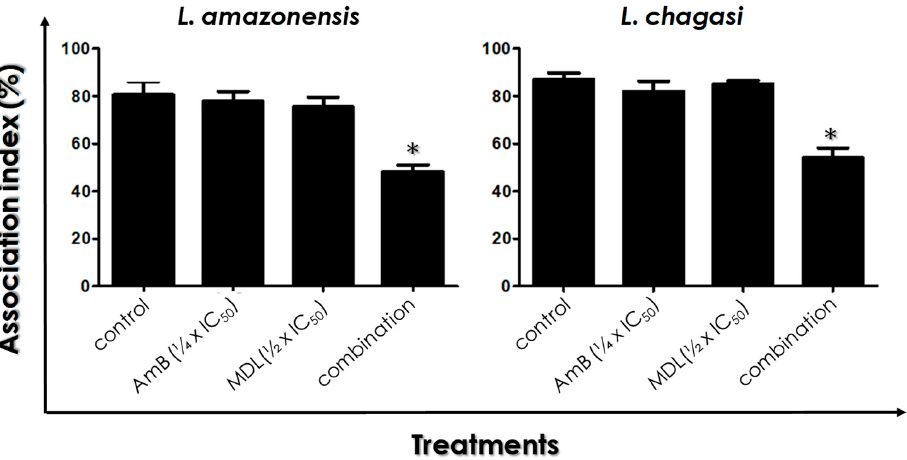
Figure 6. Effects of the combination of 1 / 4 × IC 50 value of amphotericin B (AmB) plus 1 / 2 × IC 50 value of the calpain inhibitor MDL28170 on L. amazonensis and L. chagasi promastigotes interaction with macrophages. Promastigotes were pre-treated or not (control) with the drugs in combination for 4 h prior to macrophage–parasite interaction. Macrophages were then infected with promastigote forms for 24 h at 37 °C, and macrophage monolayers were washed with PBS to remove unbound parasites. The association index was determined as described in Materials and Methods. Parasites were also incubated in the presence of either the 1 / 4 × IC 50 value of AmB or the 1 / 2 × IC 50 value of MDL28170 prior to Leishmania–Macrophage interaction. The results represent the mean and standard deviation of three independent experiments and the asterisks highlight significant differences when compared to control ( p <